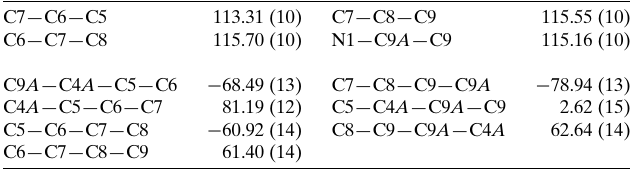
Table 2 Selected bond and torsion angles ( (cid:3) ) for 1b .